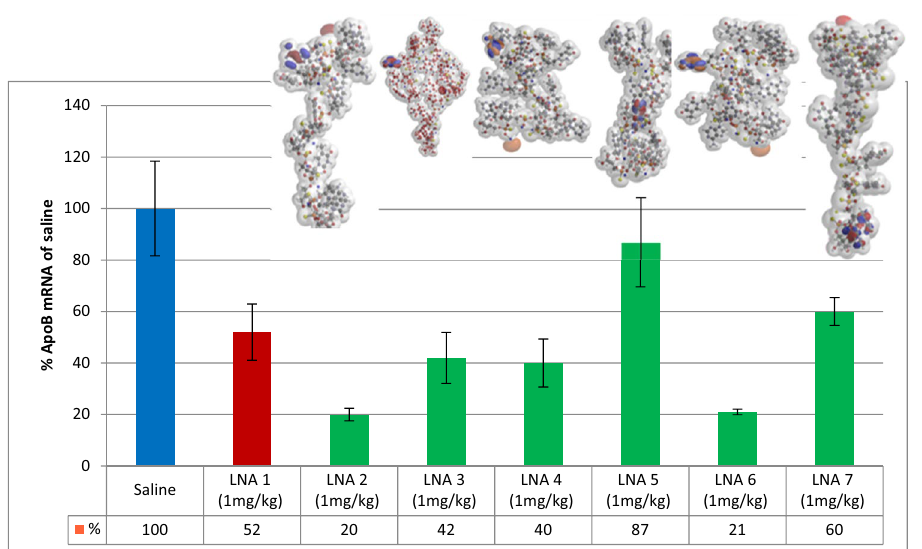
Figure 4. Antisense activity of LNA diastereoisomers targeting ApoB-100. Diversity of diastereoisomer knockdown of target ApoB in livers of mice (C57BL/6qBom) (n = 5) dosed once intravenously at 1 mg/kg on day 0 and taken down day 3 (60 h). Target mRNA level (% of saline control) were measured in liver tissue. Blue, saline control; red LNA 1 random mixture of stereoisomers. Green, stereo-defined isomers with identical nucleobase sequence and nucleoside design as LNA